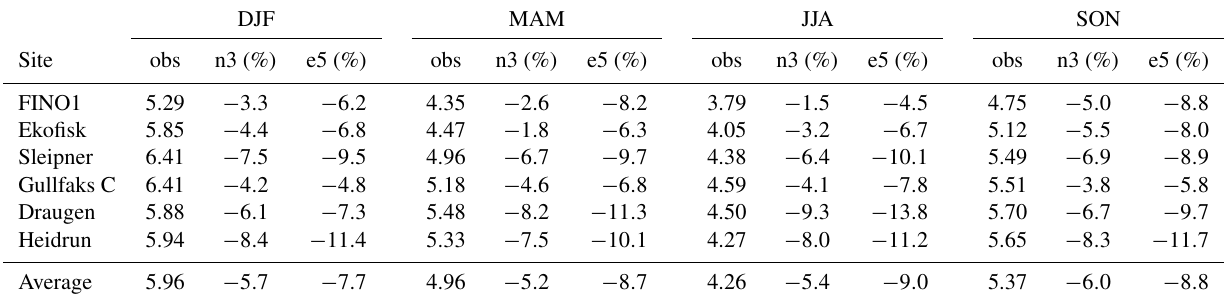
Table 3. Seasonal standard deviation of the observed (obs) wind speed (ms − 1 ) and the model deviation in percentage (%) for both NORA3 (n3) and ERA5 (e5). “DJF” corresponds to December–January–February, “MAM” is March–April–May, “JJA” is